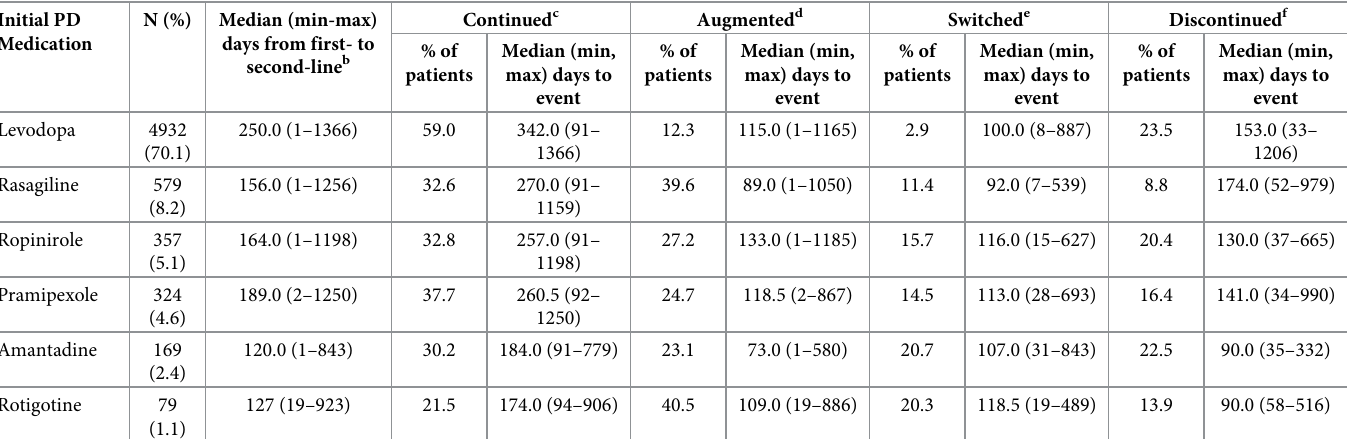
Table 2. The most common first-line PD medication for US patients in the IBM marketscan database a